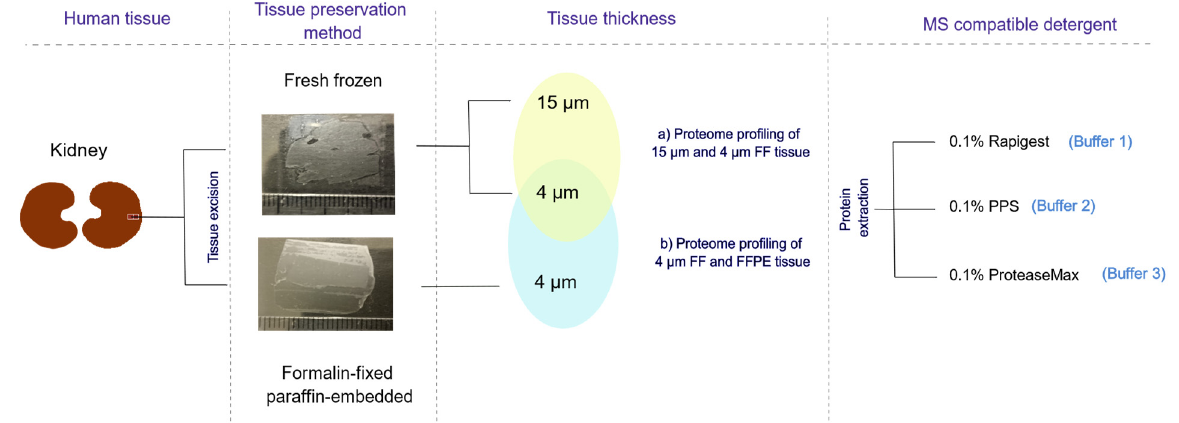
Figure 1. Scheme of the study of protein extraction from the FF and FFPE tissues with MS-compatible buffers. Proteins were analyzed using 4 μ m and 15 μ m thick FF tissue to examine effect of the tissue thickness on the protein identification with several different methods. Further, identified proteins were compared between 4 μ m thick FF and FFPE tissues to evaluate appropriateness of the minute amounts of the FFPE tissues to be used with the MS-compatible protocols.